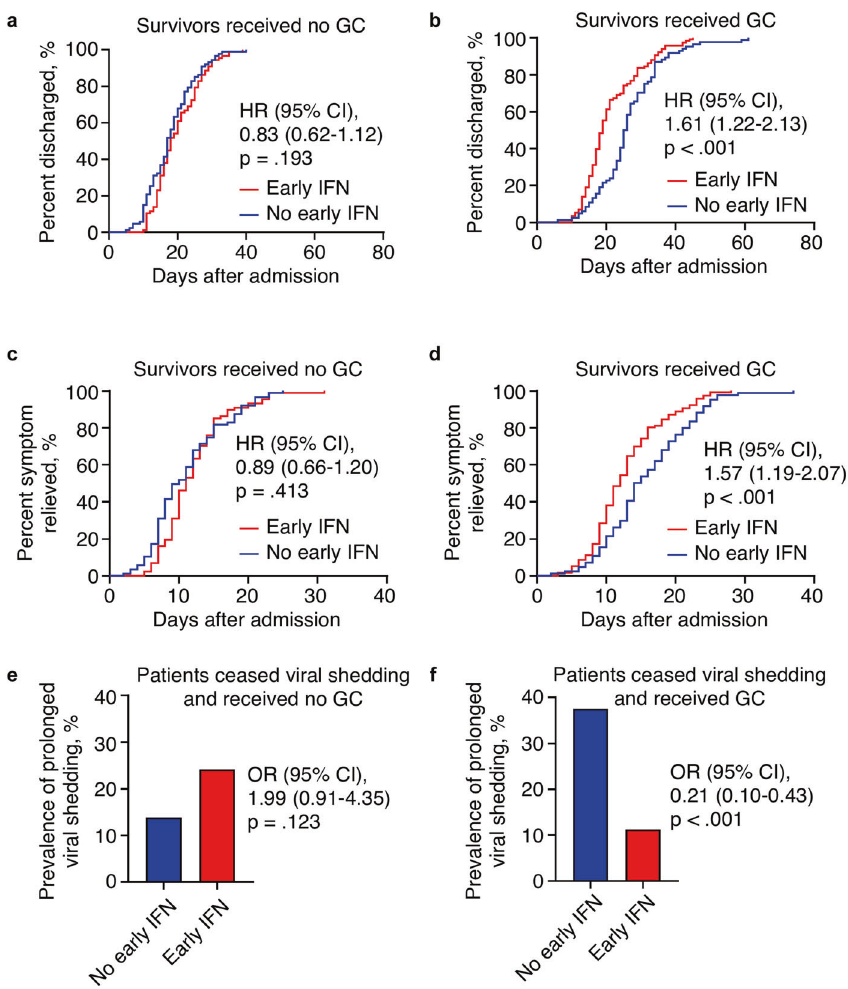
Fig. 1 Association of early IFN therapy with early recovery among COVID-19 patients with GC therapy. a , b Cumulative incidence curves for hospital discharge among survivors without ( a ) or with GC ( b ). n = 87 for a , 116 (early IFN) and 84 (no early IFN) for b . c , d Cumulative incidence curves for symptom relief among survivors without ( c ) or with GC ( d ). n = 87 for c , 116 (early IFN) and 84 (no early IFN) for d . e , f Bar graph of PVS prevalence among patients ceased viral shedding before discharge without ( e ) or with GC ( f ). n = 87 for e , 116 (early IFN) and 88 (no early IFN) for